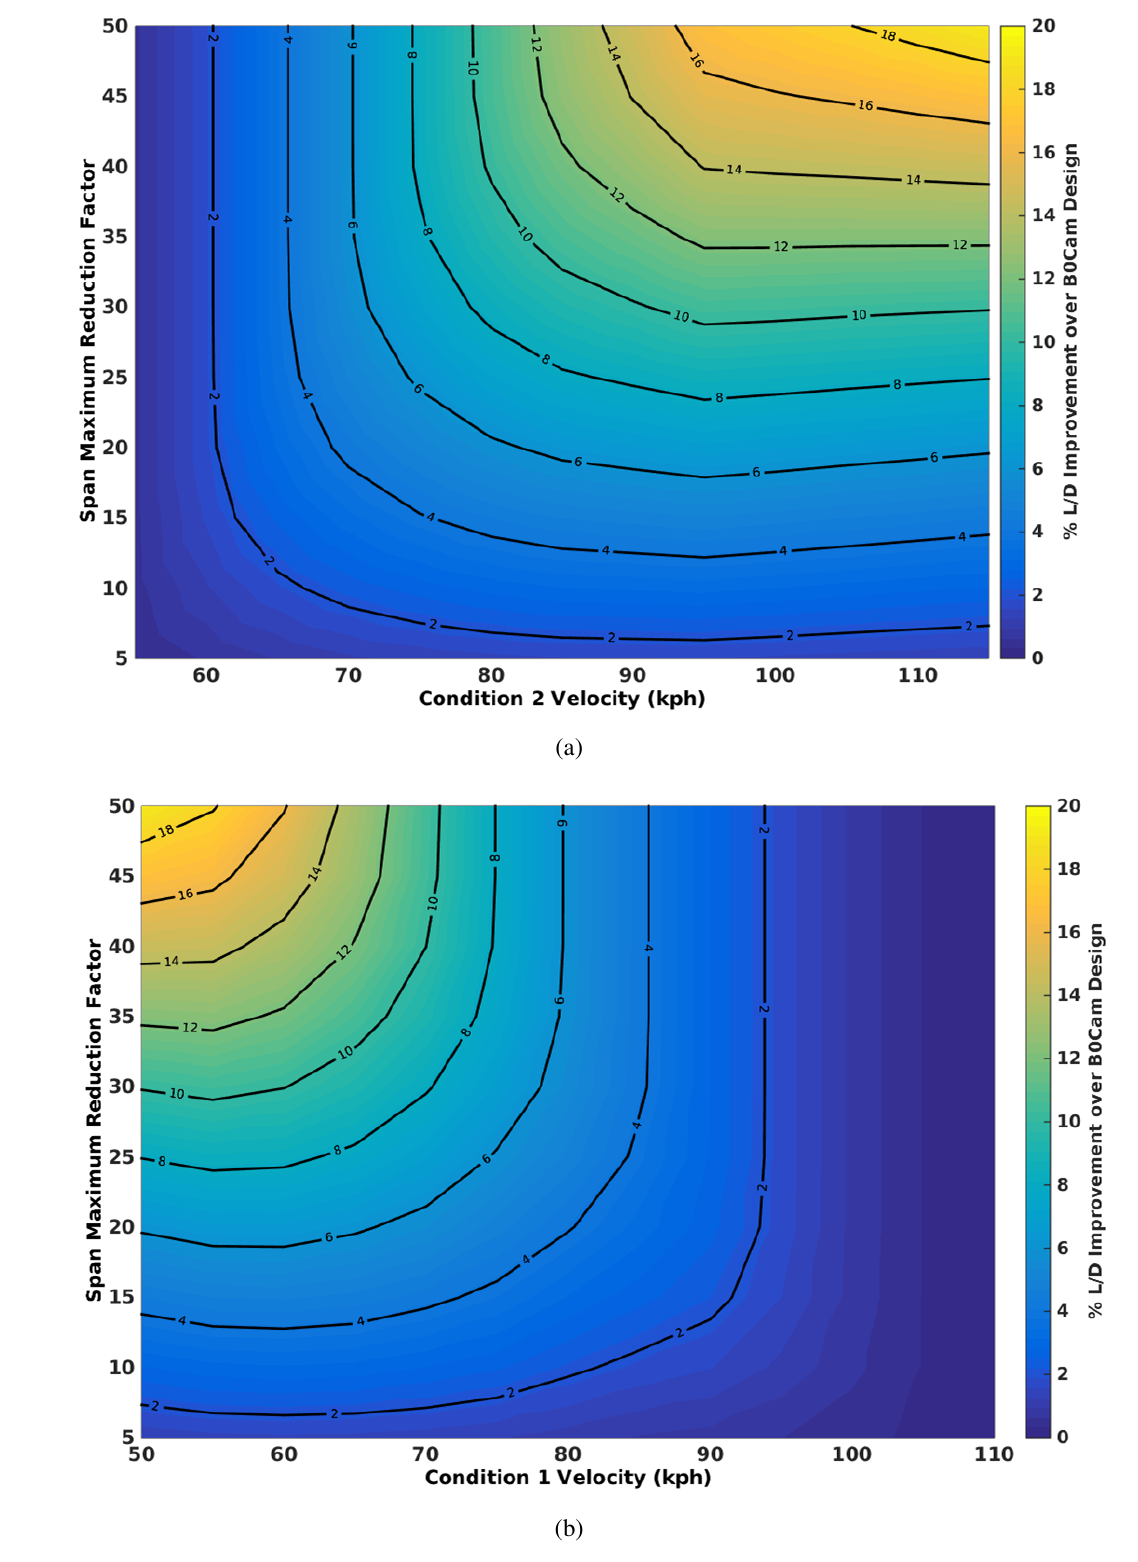
Figure 16. Effect of maximum span modification on aerodynamic efficiency for optimum span with camber over variable speed ranges normalised to the baseline camber design. ( a ) Aerodynamic efficiency for low speed fixed at 50 kph; ( b ) aerodynamic efficiency for high speed fixed at 115